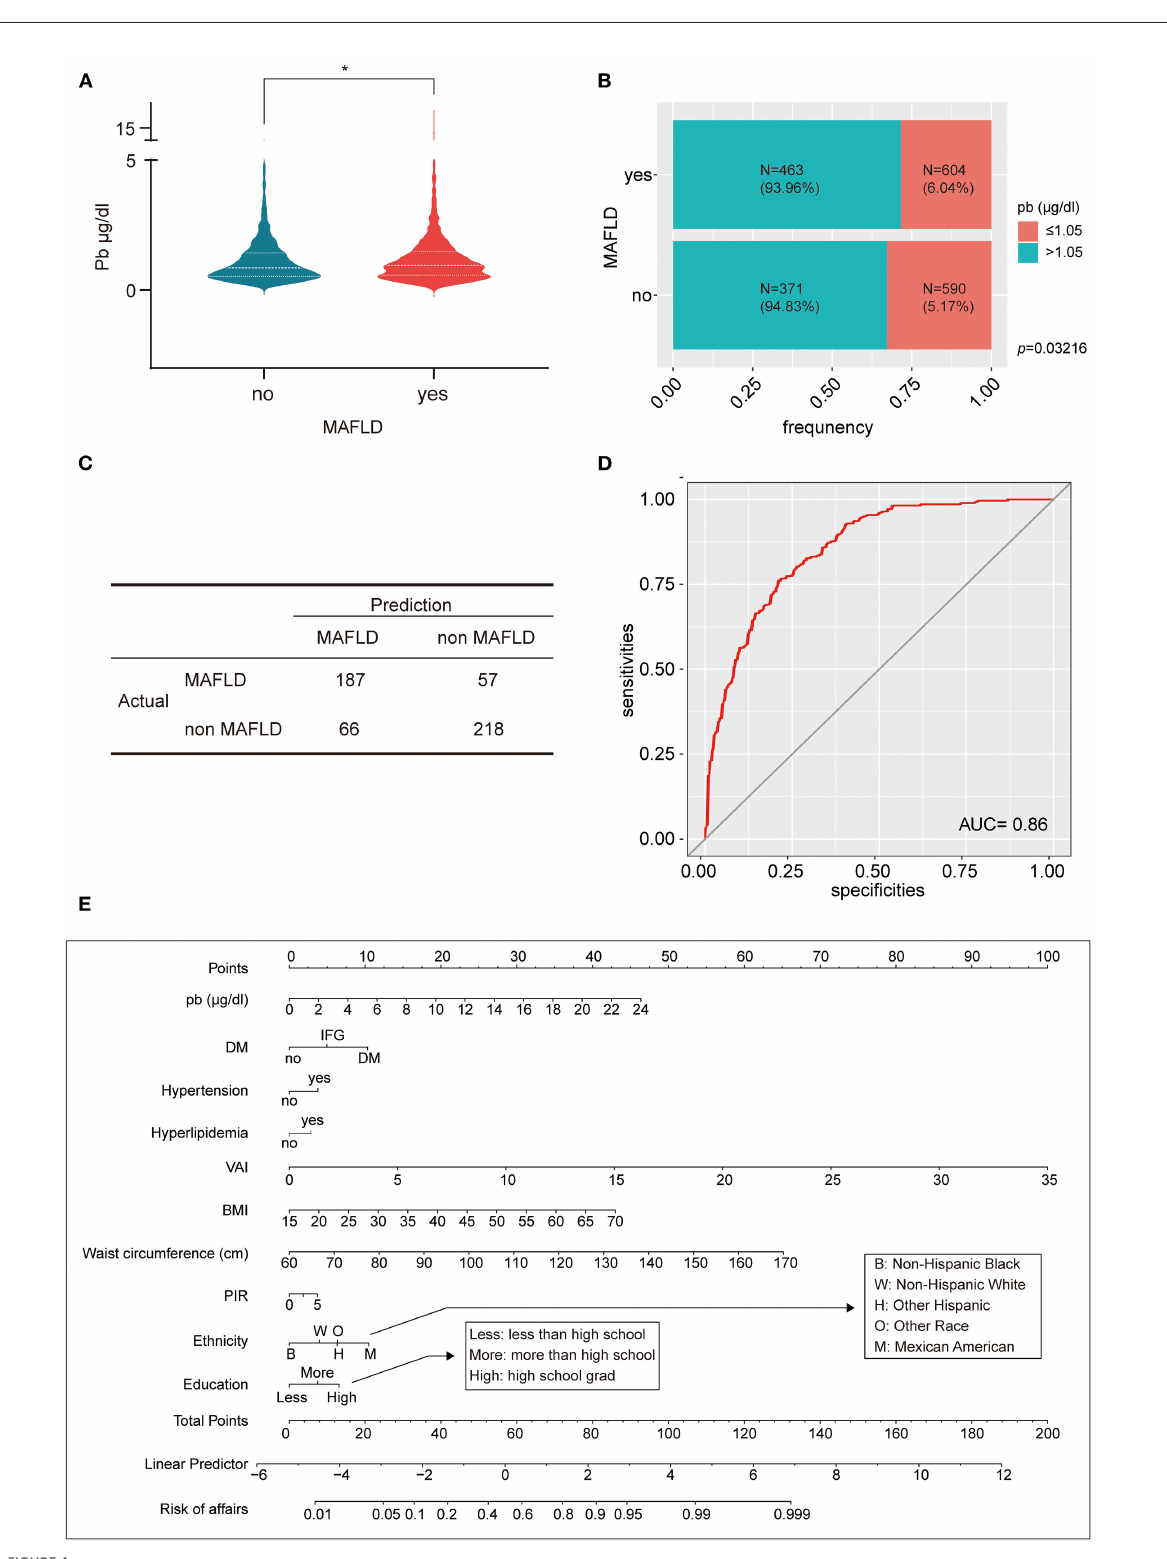
FIGURE4 Lead affects the development of MAFLD. (A) The violin plot reflects that MAFLD had higher blood lead concentration than non-MAFLD; (B) The percent bar chart reflects that the MAFLD group a greater proportion of individuals with blood lead concentration > 1.5 µ g/dl; (C) The four-grid table shows the difference between the predicted value and the actual value of the multifactorial logistic regression model in the validation set. (D) The ROC curve evaluated the effectiveness of multifactorial logistic regression model, AUC = 0.86; (E) A lead exposure related nomogram for MAFLD prevalence. * p -value <